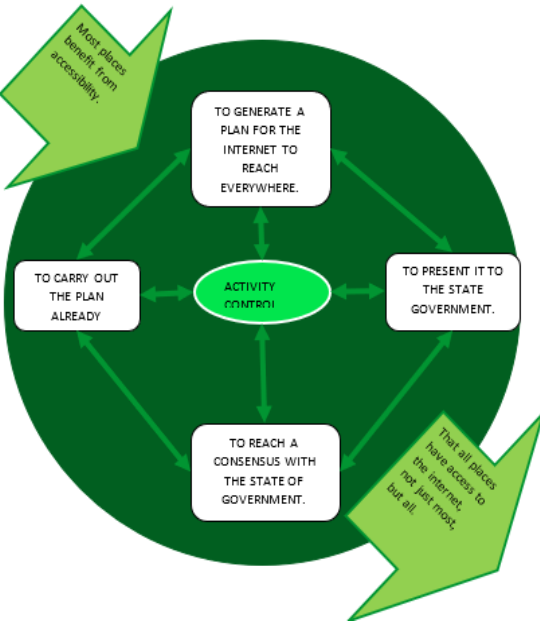
Fig. 9. Conceptual model applied to the use of the